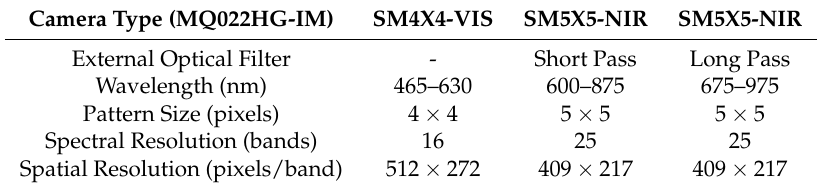
Table 1. Selection of available XIMEA hyperspectral cameras for our system (Generation 1).